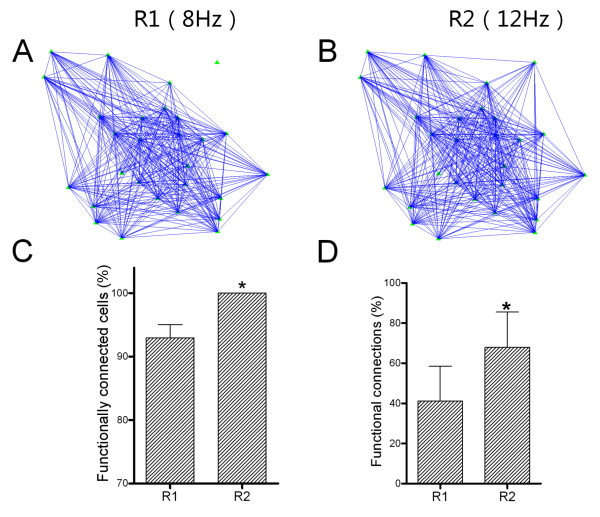
Functional connections among barrel neurons increase in response to stimulus frequencies at 8 Hz and 12 Hz, in which response one (R1) corresponds to 8 Hz and response two (R2) corresponds to 12 Hz. A ~ B) presents the functional connections (blue lines) among the barrel neurons (green symbols) under the conditions of stimulus frequencies at 8 Hz (A) and 12 Hz (B), respectively. Scale bar is 20 μm. C) shows the percentages of functionally connected neurons in barrel networks during R1 (8 Hz input) and R2 (12 Hz). D) illustrates the percentage of functional connections for each neuron with others in R1 (8 Hz input) and R2 (12 Hz). Asterisk presents p < 0.05 in paied student’s t-test.